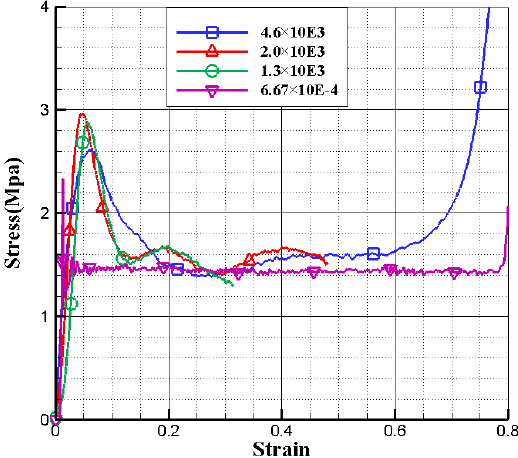
Figure 17. Mean stress–strain curve at various strain rate.